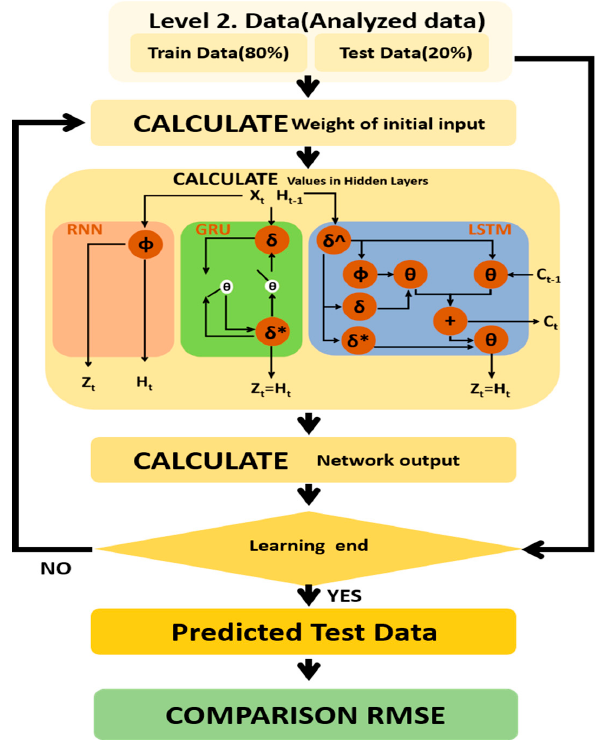
Figure 3. AI prediction workflow as δ : input, δ *: output, δ ˆ: forget gate, Φ : input modulation.